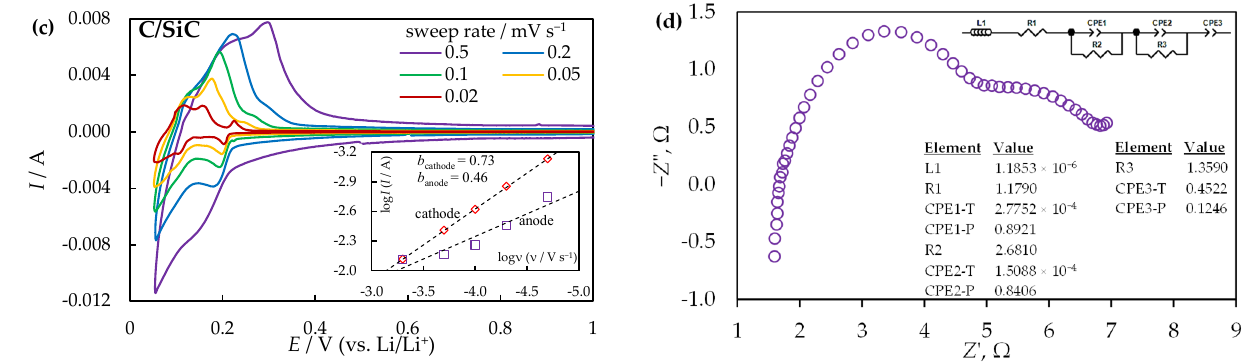
Figure 7. Cycling of C/SiC electrode: ( a ) potential change during lithiation (dashed line) and delithiation (solid line); ( b ) discharge capacity and Coulombic efficiency; ( c ) CVs at different scan rates and log( I )-log( ν ) dependencies; ( d ) EIS data with equivalent circuit diagram.